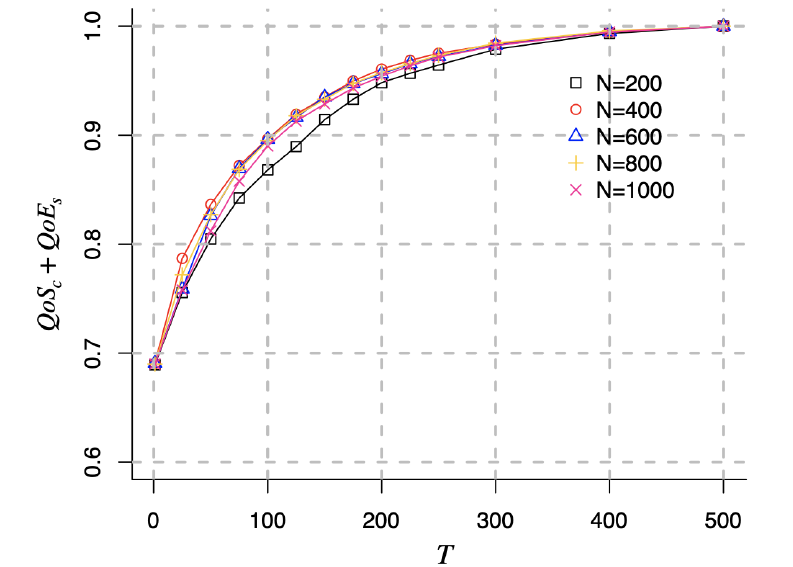
Figure 3. The overall complex QoS dynamics against the population of the temporal multilayer social network. We display the evolution of the overall complex quality measure in T temporal window, under the variation in N , and population of the M temporal multilayer social network. The overall measure is the sum of the complex ( QoS ) complex and the QoE social . Its variation was computed considering J =